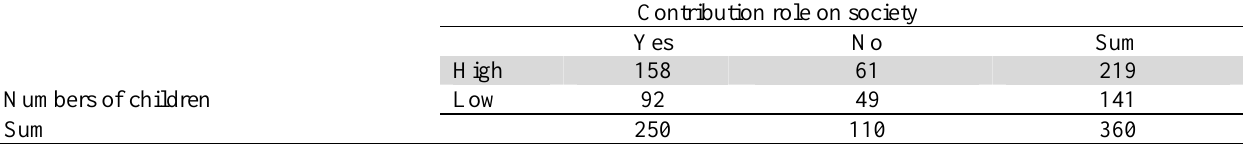
Contribution role on